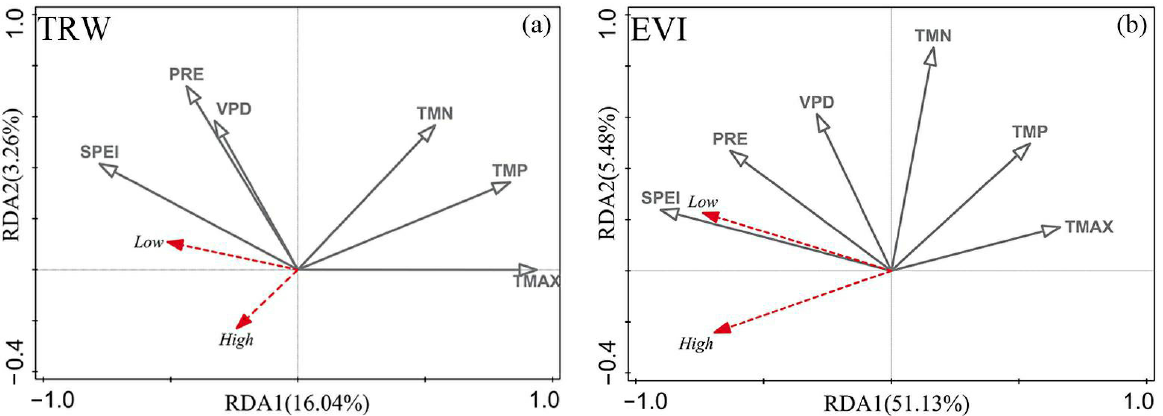
Figure 10. ( a ) Redundancy analysis of TRW and each climate factor in the Qilian Mountains region from 1960 to 2020 and ( b ) redundancy analysis of EVI and each climate factor in the Qilian Mountains region from 2000 to 2020 (High—high elevation; Low—low elevation; TMN—mean minimum temperature; TMP—mean temperature; TMAX—mean maximum temperature; SPEI—standardized precipitation evapotranspiration index; VPD—vapor pressure deficit;